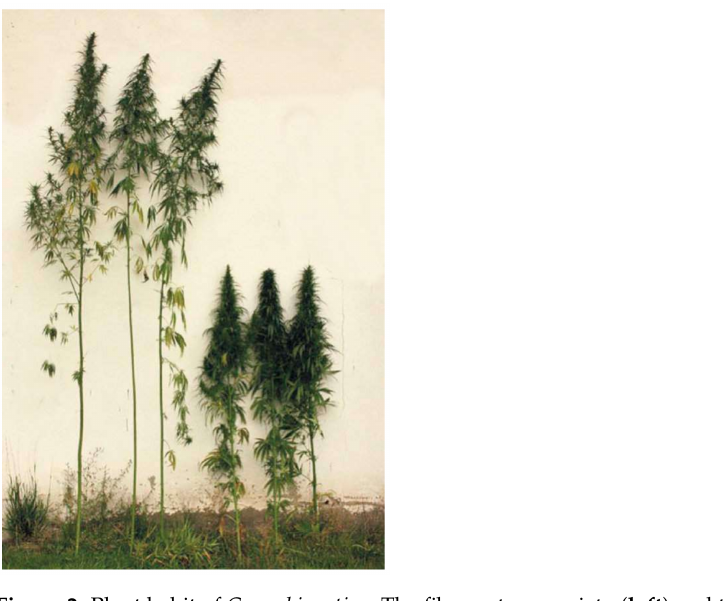
Figure 2. Plant habit of Cannabis sativa . The fibrous type variety ( left ) and the cannabinoid-seed type variety ( right